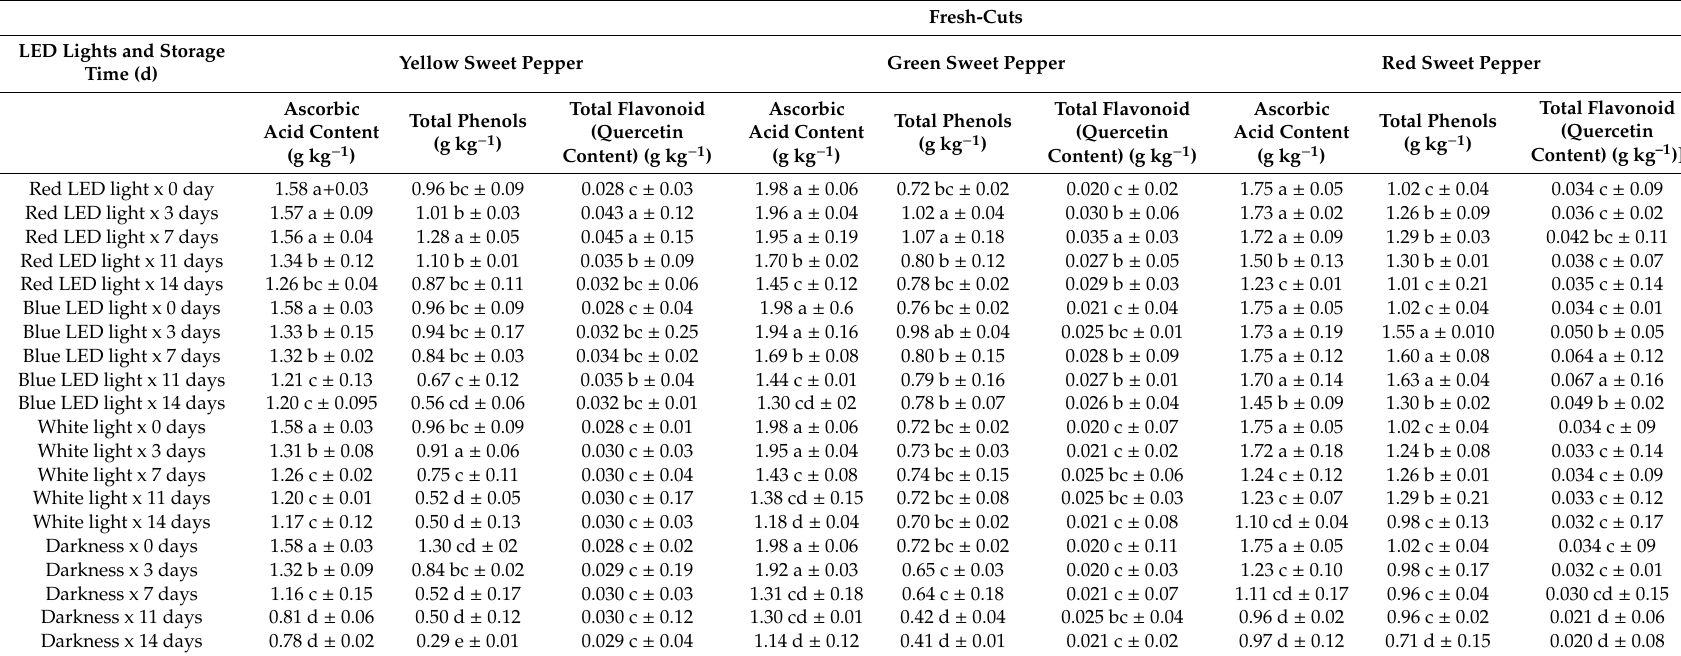
Table 2. E ff ect of LED lights and di ff erent storage times from 0 to 14 days on ascorbic acid, total phenols, and flavonoid (quercetin) concentrations in yellow, green, and red sweet pepper fresh-cuts at 7 ◦